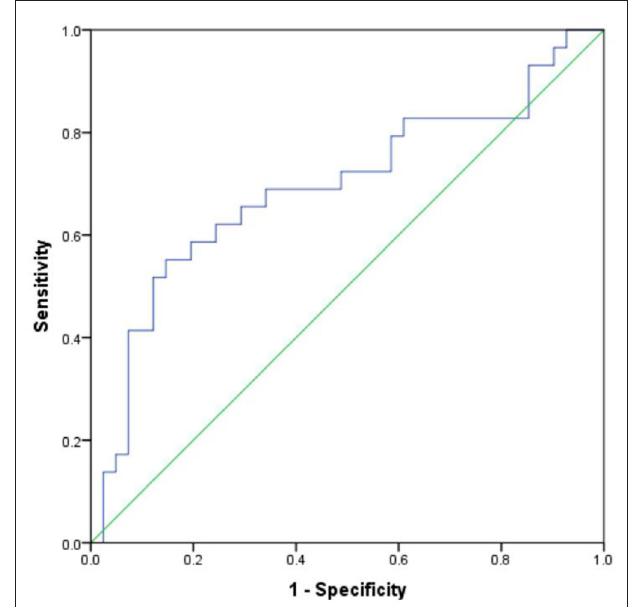
FIGURE 3 | ROC curve analysis of negative evaluation words for differentiating severity of HAMD-17